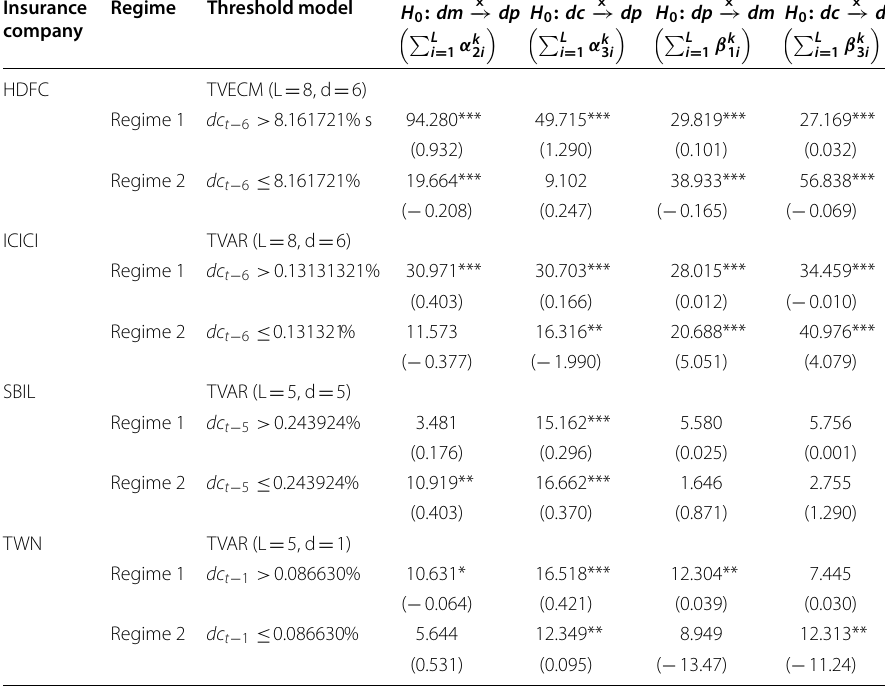
Table 7 The causality test in threshold